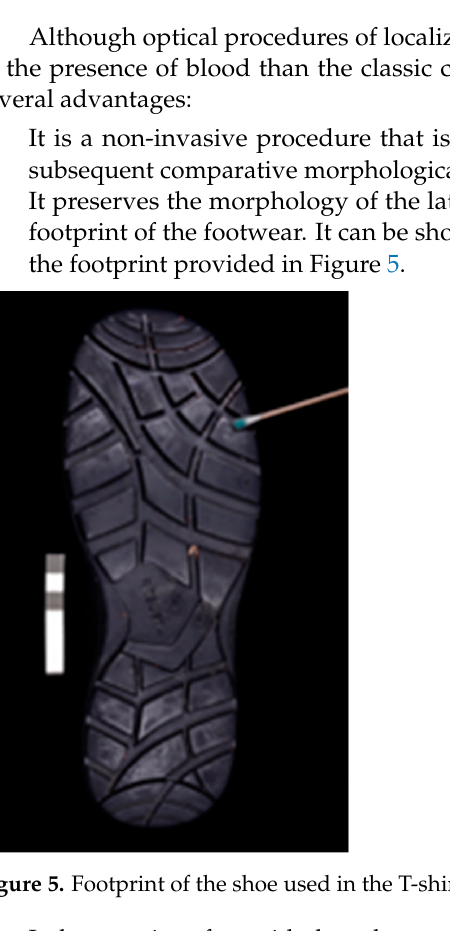
( b ) Figure 7. Images of a cotton sheet with traces of latent blood photographed: ( a ) with a conventional camera illuminated with white visible light and ( b ) Invespector system using UV illumination 365 nm. We have run multiple tests to show the capabilities of the multispectral device. Table 1 shows the right configurations for the detection of a drop of blood on different surfaces.